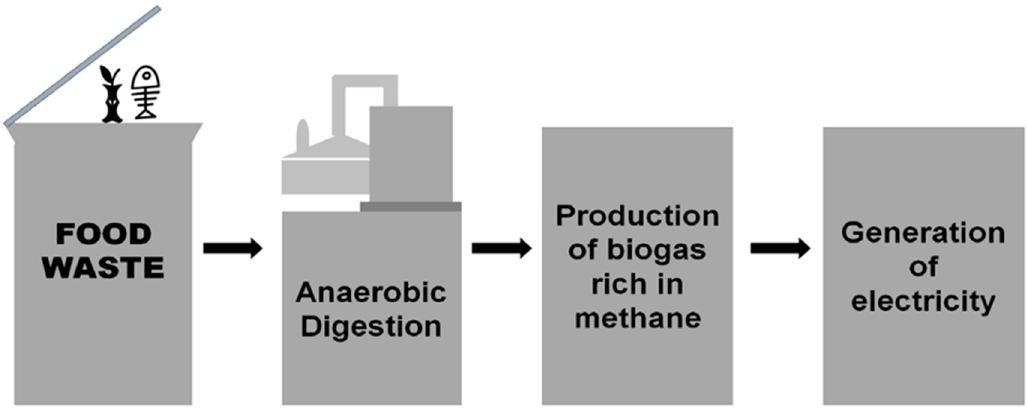
Figure 3. Waste to energy conversion by anaerobic digestion.